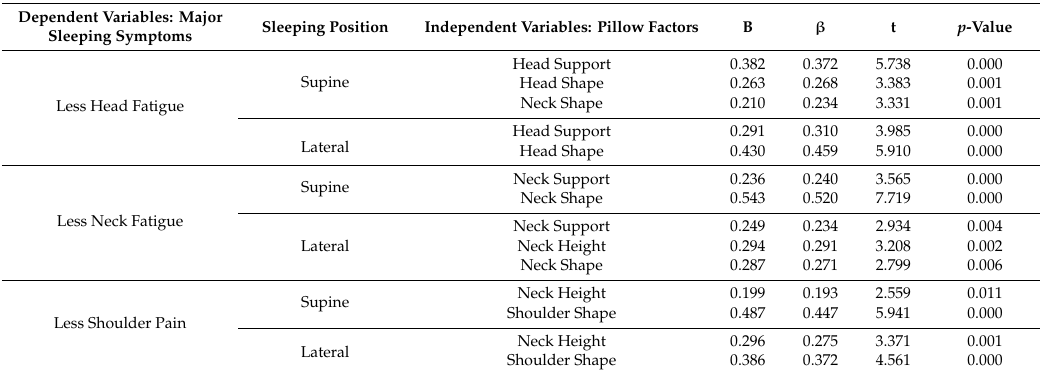
Table 8. Results of multiple linear regression analyses between major sleeping symptoms and pillow design factors according to sleeping positions.